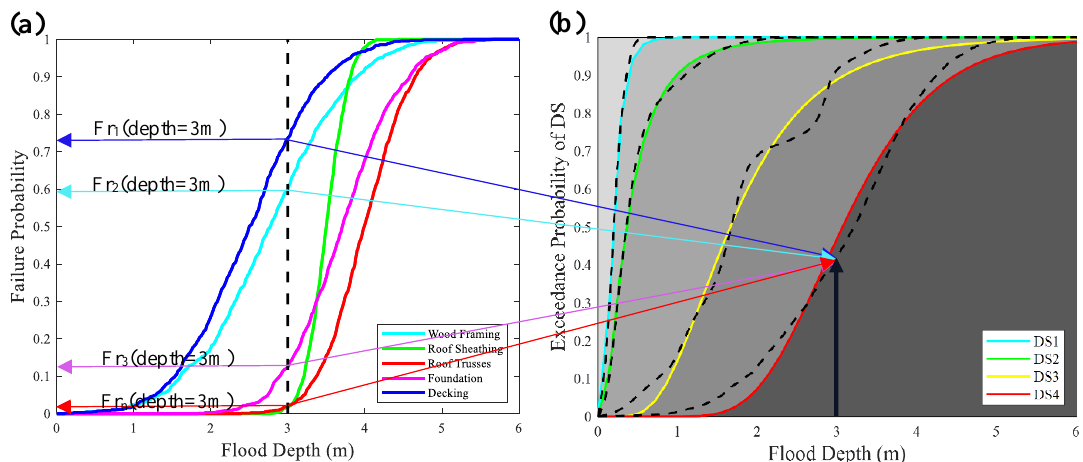
Figure 2. Components and building fragility functions: ( a ) Component fragility curves for the fourth damage state (DS4) components along with their failure probability at flood depth = 3.0 m; ( b ) Fitted (Solid lines) and non-fitted (dashed lines) building fragility curves.